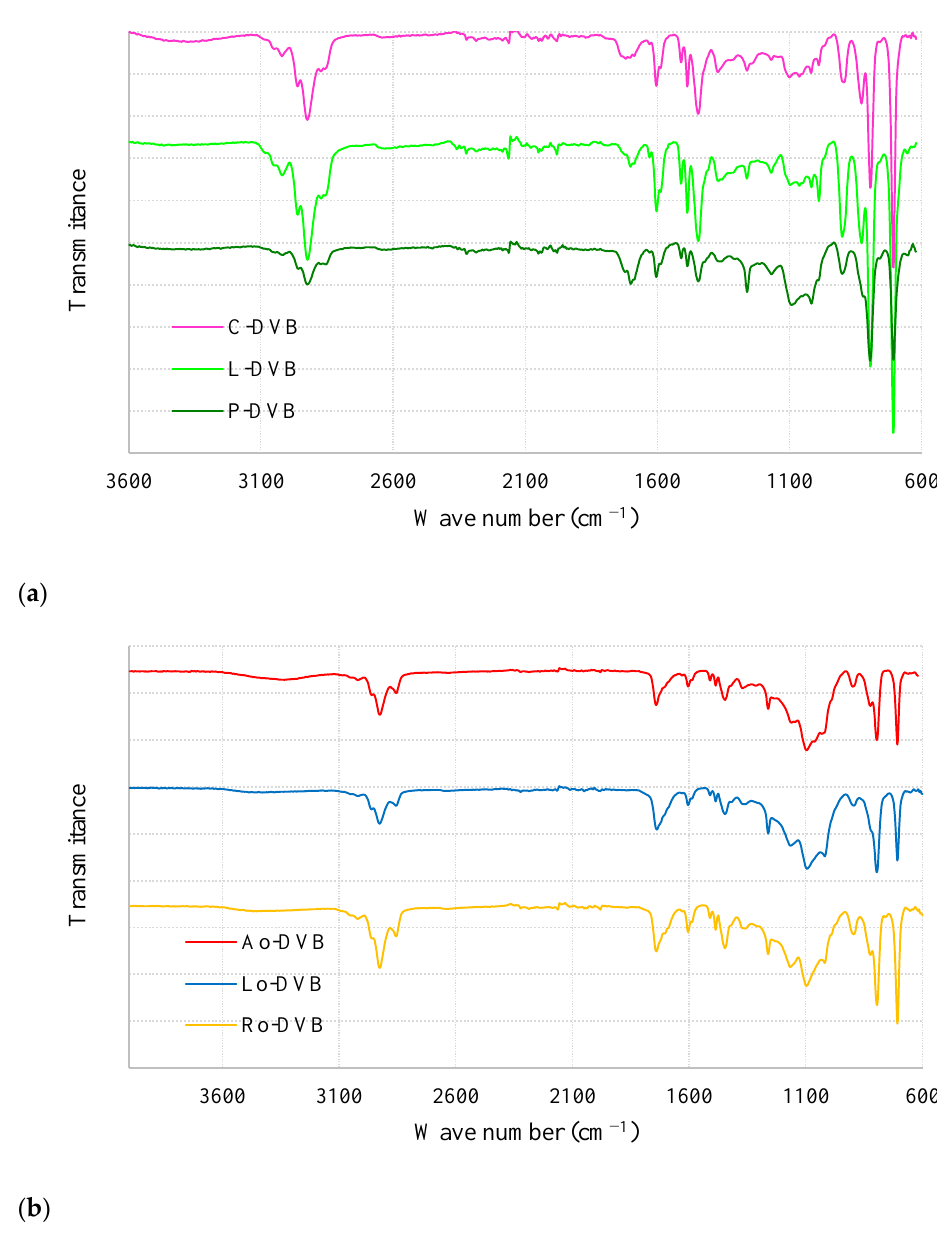
Figure 3. ATR-FTIR spectrograms of ( a ) C-DVB, L-DVB, and L-DVB and ( b ) Ao-DVB, Lo-DVB, and Ro-DVB.